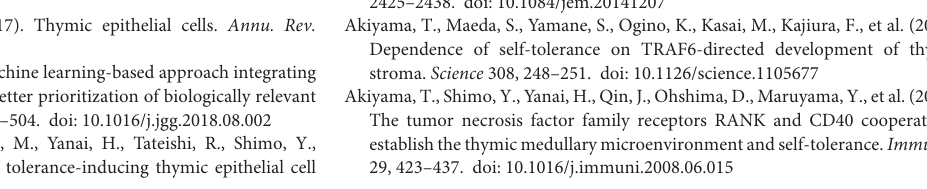
Supplementary Figure 2 | Aging-like phenotype did not observed in Sirt6 cKO mice. (A) Representative figure of thymi isolated from 8-month-old WT and Sirt6 cKO mice. (B) Thymic weight normalized to body weight (left) and the thymocytes cellularity (right) in 4-week-old WT and Sirt6 cKO mice and 8-month-old WT and Sirt6 cKO mice. WT (4-week-old: n = 4; 8-month old: n = 5) and Sirt6 cKO mice (4-week-old: n = 4; 8-month-old: n = 9). (C,D) Hematoxylin and eosin (H&E) staining (C) and Masson’s Trichrome staining (D) stained sections of thymi from 8-month-old WT and Sirt6 cKO mice. Scale bars: 500 µ m. (E,F) Representative flow cytometric profiles (E) and frequency (F) of naïve T cells (CD62L + CD44 − ) in CD4 + (left) or CD8 + (right) splenocytes from 8-month-old or 4-week-old WT and Sirt6 cKO mice (4-week-old: n = 14 per group; 8-month-old: n = 10 per group). Supplementary Figure 3 | Decreased mTECs in Sirt6 cKO mice is not caused by apoptosis. Flow cytometry plots and frequency for the staining of Active Caspase3 in WT and Sirt6 deficient mTECs. N = 4 per group. ∗∗ p < 0.01 (Student’s t -test). Supplementary Figure 4 | The maturation and proliferation of cTECs were not influenced in Sirt6 cKO mice. (A) Flow cytometry plots and frequency for BrdU + cTECs from 2-week-old Sirt6 cKO mice and littermates. (B) Representative flow cytometry plots and frequencies of CD40 (upper) and MHC II (lower) expressed on cTECs. (C) Cell numbers of CD40 + cTECs (upper) and MHC II high cTECs (lower) of 4-week-old Sirt6 cKO mice and littermates. N ≥ 4 per group. ∗ p < 0.05 (Student’s t -test). Supplementary Figure 5 | The expression of TNFRF in mTECs. Quantitative Real-Time PCR analysis of Cd40 , Rank , and Ltbr mRNA expression in mTECs (CD45 − EpCAM + UEA-1 + Ly51 − ) sorted from wild-type and Sirt6 cKO mice. Data were normalized to Hprt mRNA levels. ∗ p < 0.05 (Student’s t -test). Supplementary Figure 6 | SPIB expression was up-regulated in Sirt6 cKO TECs. (A) The scatter plot showed the difference of transcription factors between wild-type and Sirt6 deficient mTECs. Genes with significant changes were color-coded in the plot. Red indicated that genes up-regulated in Sirt6 cKO mTECs, while blue indicated that genes down-regulated in Sirt6 cKO mTECs. The color of genes was under the criterion of p < 0.05. (B) The original picture of western blot result for Figure 4H . (C) Sorting strategies for Figures 4I,J . Supplementary Figure 7 | Sirt6 deficient mTECs began to decrease in neonates, but not in E16.5. (A) Frequencies and absolute numbers of TECs (CD45 − EpCAM + ), cTECs (CD45 − EpCAM + UEA-1 − Ly51 + ) and mTECs (CD45 − EpCAM + UEA-1 + Ly51 − ) obtained from E16.5 Sirt6 cKO mice and littermates. (B) Frequencies and absolute numbers of TECs (CD45 − EpCAM + ), cTECs (CD45 − EpCAM + UEA-1 − Ly51 + ), mTECs (CD45 − EpCAM + UEA-1 + Ly51 − ), CD80 + mTECs (CD45 − EpCAM + UEA-1 + Ly51 − CD80 + ) obtained from WT and Sirt6 cKO neonatals. N ≥ 4 per group. ∗ p < 0.05 and ∗∗ p < 0.01 (Student’s t -test). Supplementary Figure 8 | The development of thymocytes in WT and Sirt6 cKO mice. (A) Gating strategies for Figure 5C . (B) FACS plots for Figures 5D,E . (C) Absolute numbers of CD4 + splenocytes and CD8 + splenocytes of wild-type and Sirt6 cKO mice. (D) Gating strategies for Figure 5I